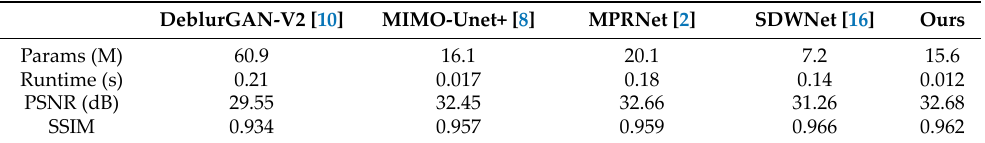
Table 3. Parameters and runtimes comparison. The runtimes are the average testing time per image in the GoPro test dataset [7]. All models are tested with a single TITAN RTX GPU. The units of parameters and runtime are millions and seconds, respectively.